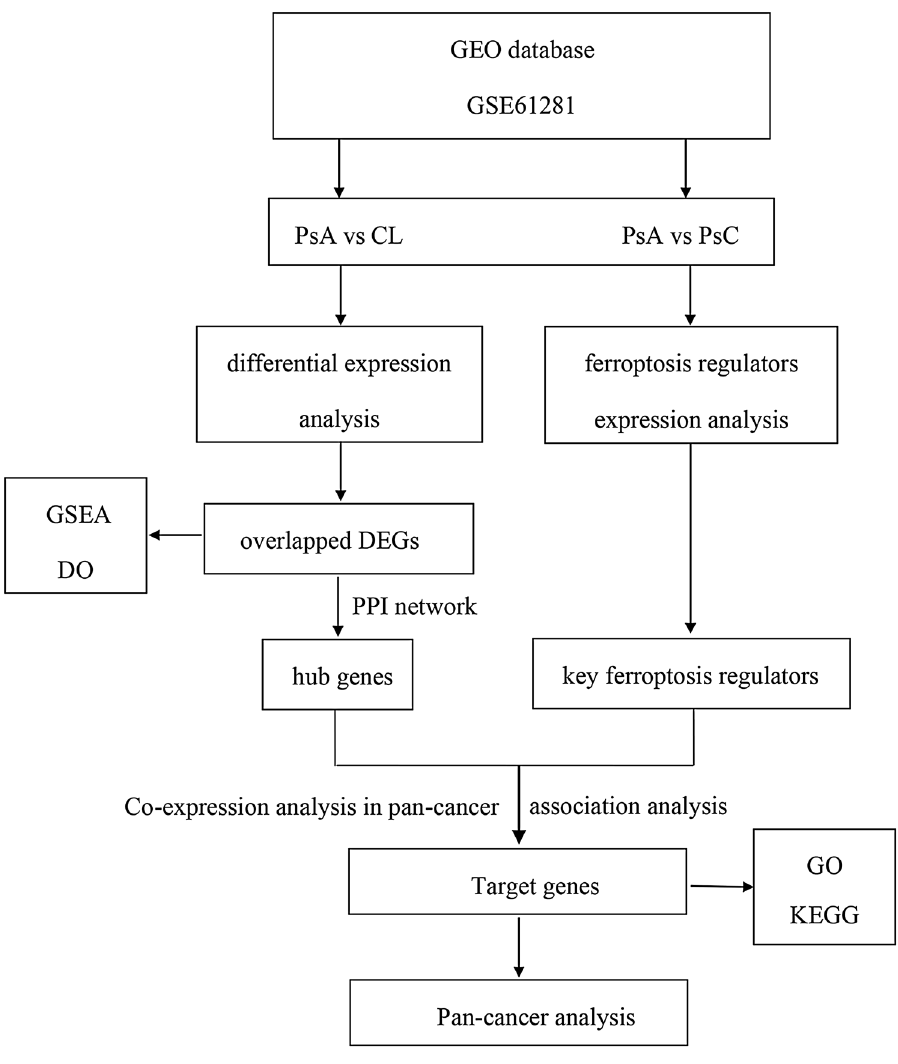
Figure 1. Flowchart of